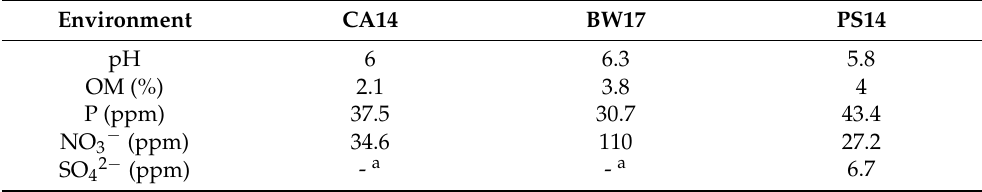
Table 2. Soil tests in three locations of Argentina where the field experiments were conducted (in the top 20 cm of the soil). OM: organic matter; P: phosphate; NO 3 − : nitrate; SO 42 − : sulphate; CA14: Cabildo 2014; BW17: Barrow 2017; PS14: Pieres